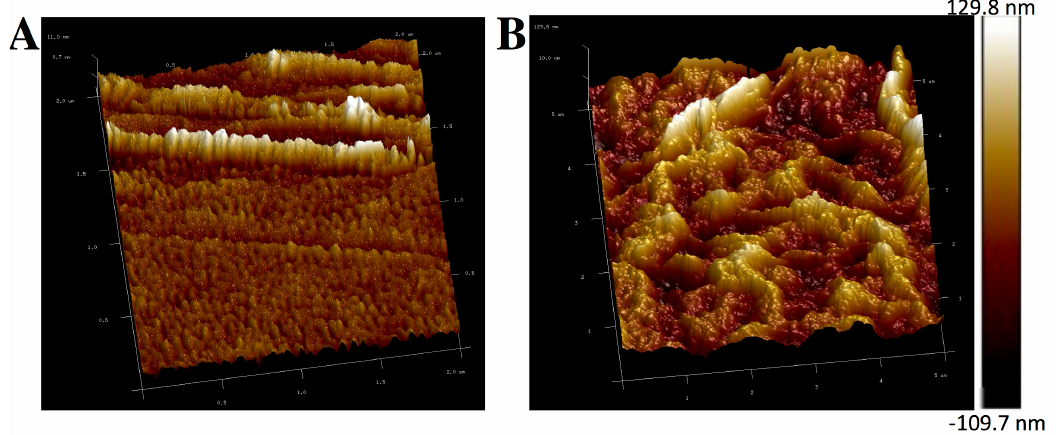
Figure 5. AFM images of bare ( A ) gold electrode and ( B ) Gr/ L -cys/Au electrode.